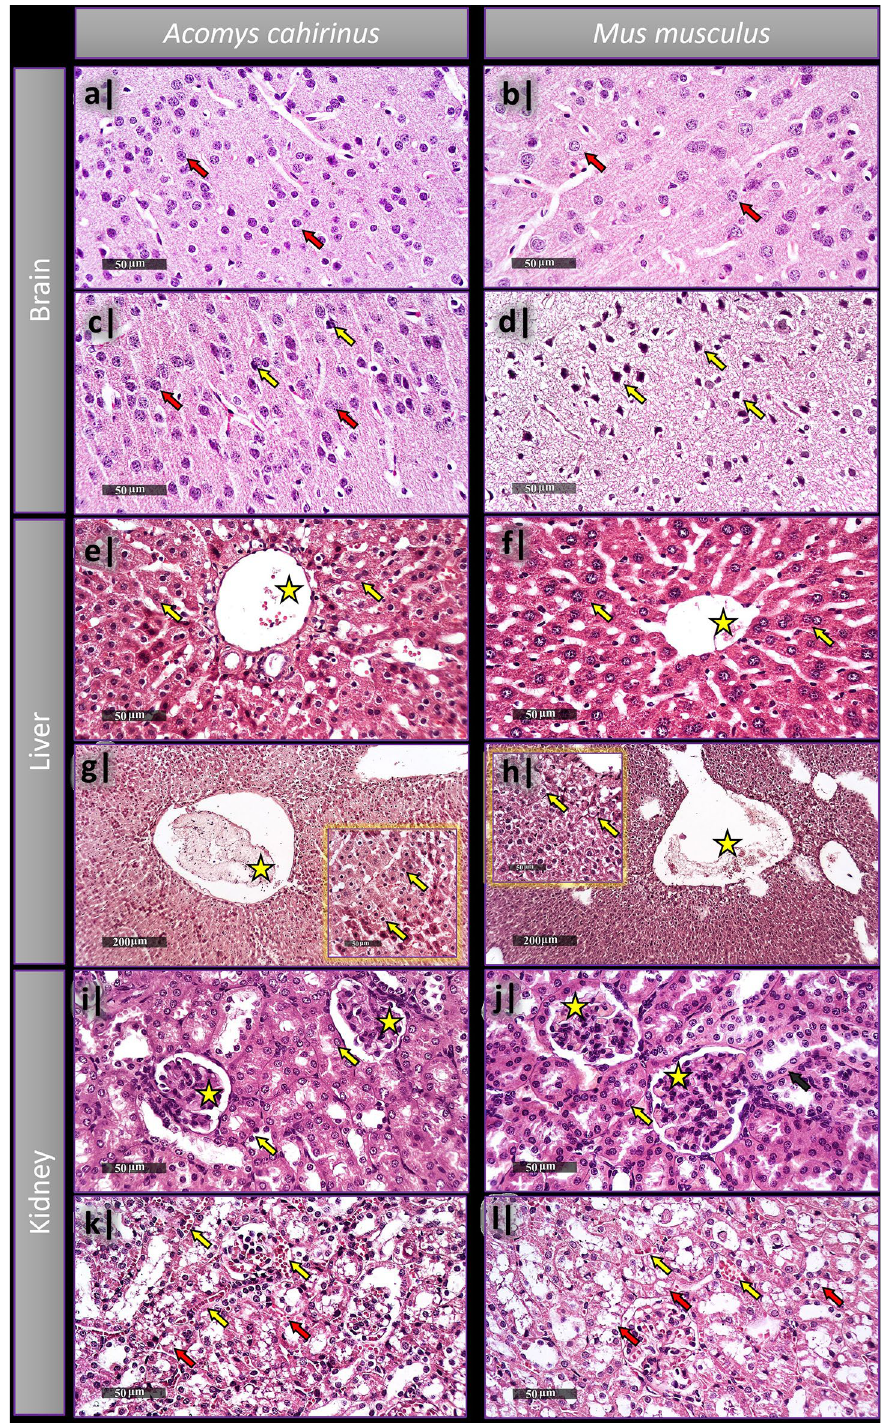
Figure 3. Histopathological examination of brain ( a–d ), liver ( e–h ), and kidneys ( i–l ) of Acomys cahirinus and Mus musculus following single acute administration of LA. ( a,b ) Cortical region of brain in normal control samples of Acomys ( a ) and Mus ( b ) shows intact nuclear details (red arrows). ( c ) Treated Acomys group sample shows almost intact cortical neurons (red arrows) with intact intercellular brain matrix, and few abnormal degenerative changes (yellow arrows). ( d ) Treated Mus group sample with severe neuronal degenerative changes observed as structureless angular cell bodies (Yellow arrows) and severe vacuolization of brain matrix. ( e,f ) normal control liver samples of Acomys ( e ) and Mus ( f ), both demonstrate the common intact features of hepatic tissue with intact subcellular details (yellow arrows) and hepatic vasculatures (yellow star). ( g ) Treated Acomys group sample shows severe dilatation of hepatic central veins (yellow star), moderate degenerative changes with multiple pycnotic nuclei (yellow arrows). ( h ) Treated Mus group sample also shows severe dilatation of central hepatic vein (yellow star) with diffuse vacuolar degenerative changes (yellow arrows) all over different zones of hepatic lobules. ( i,j ) Normal control kidneys samples of Acomys ( i ) and Mus ( j ) show the common histological features of renal parenchyma with intact renal corpuscles (yellow stars) and tubular epithelium (yellow arrows). Both treated groups of Acomys ( k ) and Mus ( l ) show severe necrotic and degenerative changes in the renal tubular epithelium with lost luminal border integrity (red arrows) and mild congested intratubular blood